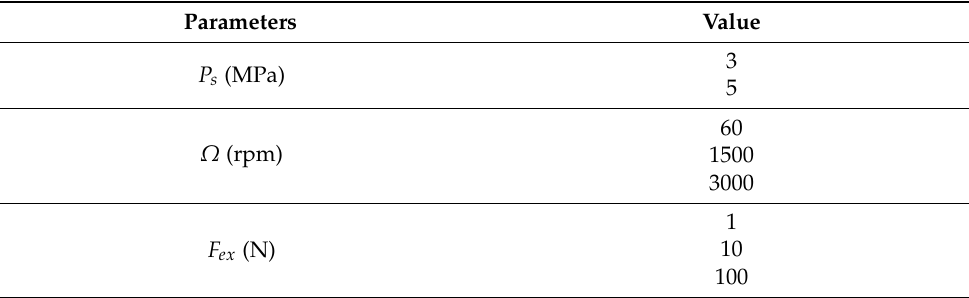
Table 2. Working parameters of the